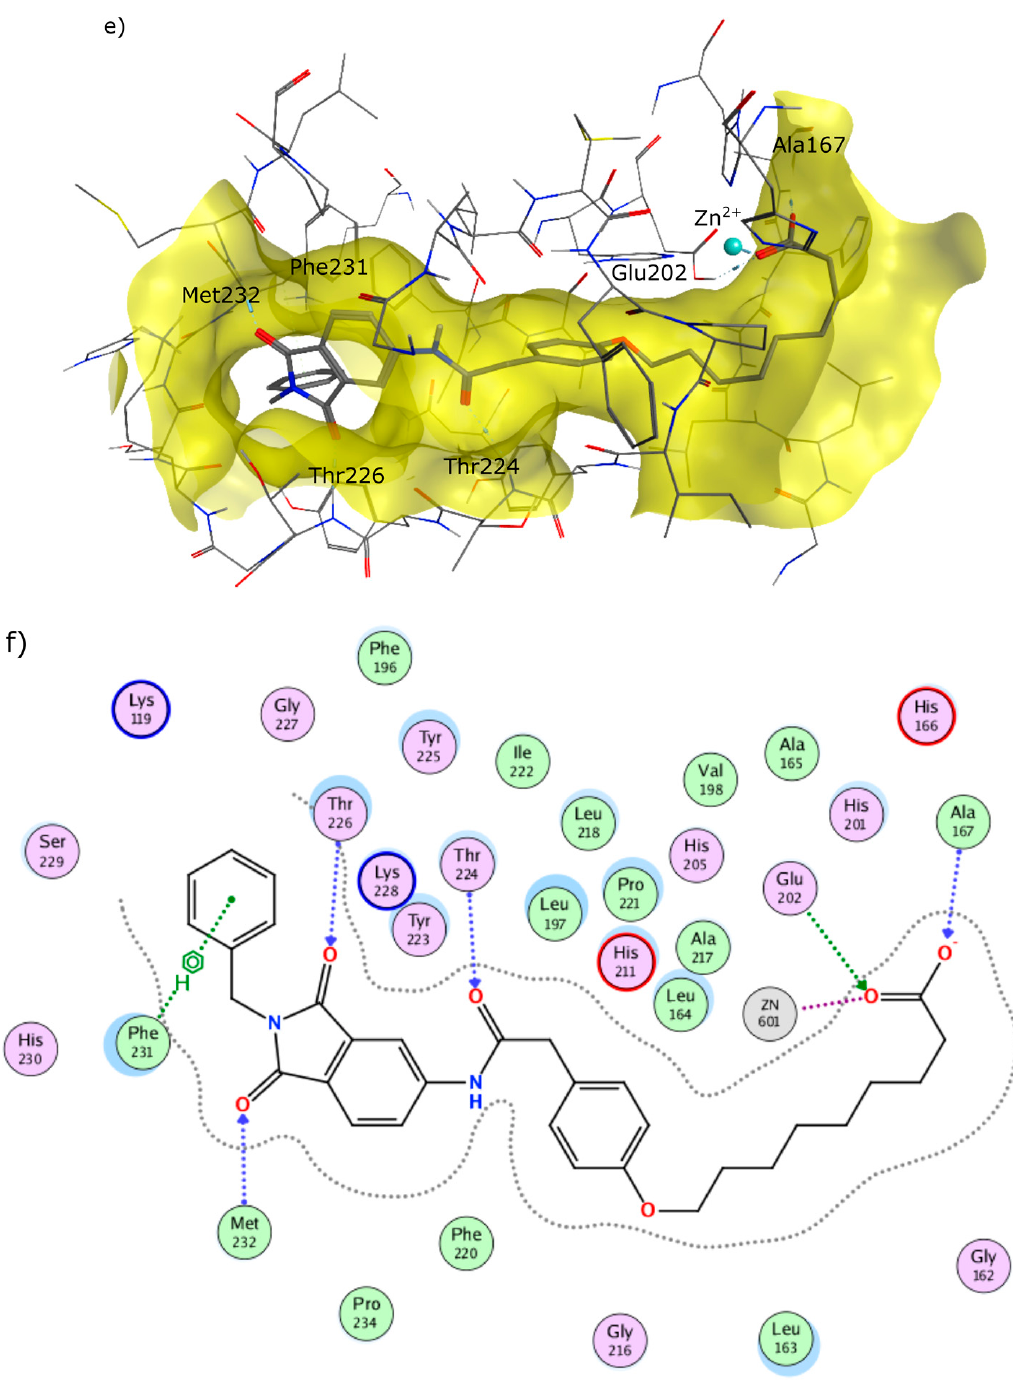
Figure 5. Potential binding modes of 14i in MMP-7 and MMP-13, ( a ) non zinc-binding mode in MMP-7; ( b ) interaction map of the non zinc-binding pose in MMP-7; ( c ) zinc-binding mode in MMP-7; ( d ) interaction map of the zinc-binding pose in MMP-7; ( e ) zinc-binding docking pose in MMP-13; ( f ) interaction map of the zinc-binding pose in MMP-13.